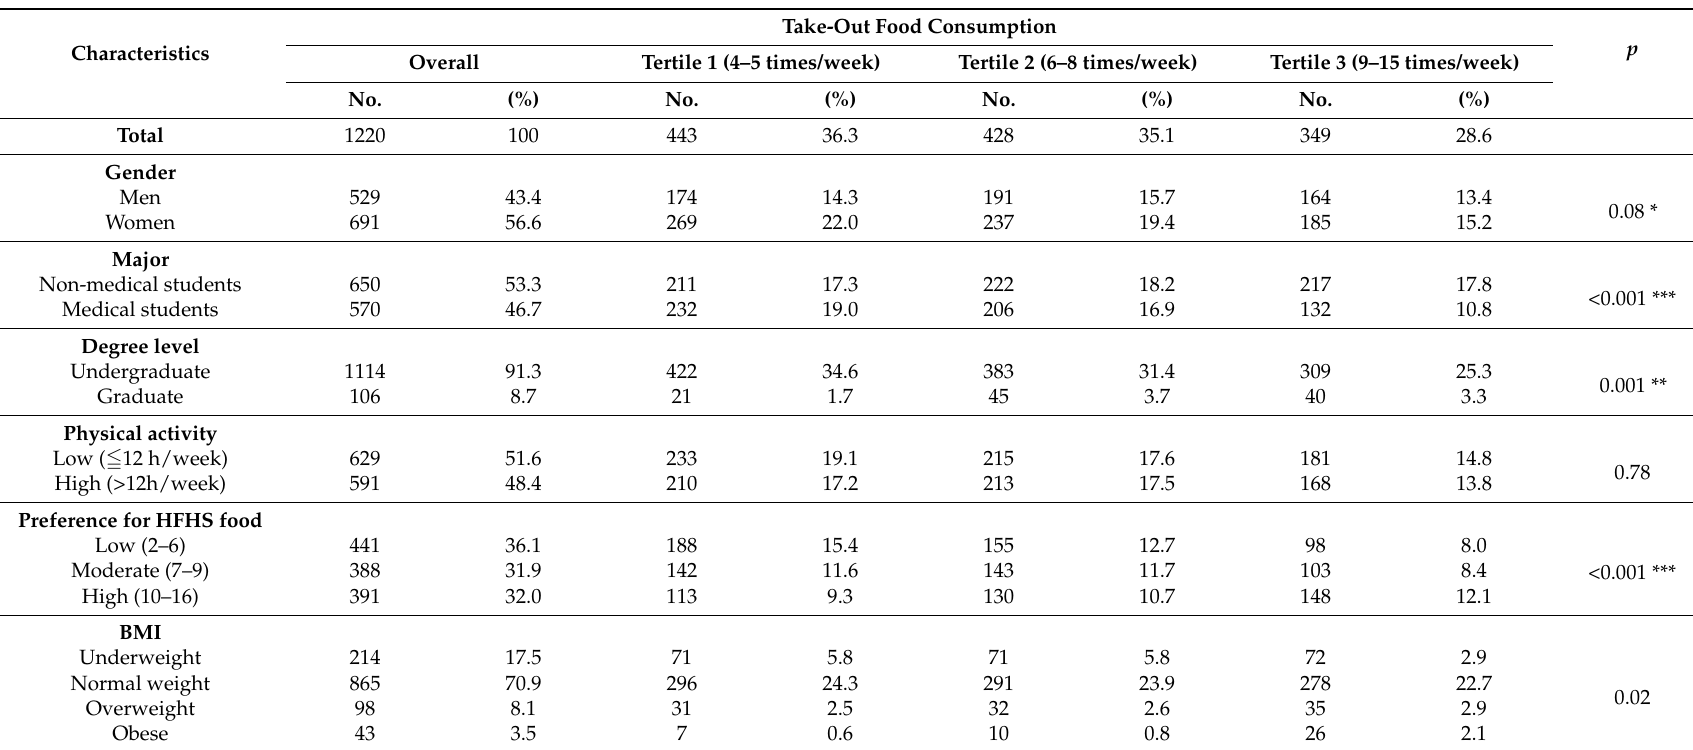
Table 2. Number of individuals across personal and lifestyle characteristics as well as categories of take-out food consumption. HFHS: high fat and high sugar.